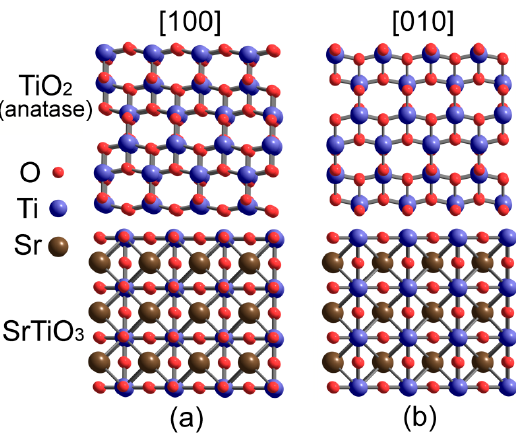
Figure 10. Structure of the heterointerface anatase TiO 2 (001) on SrTiO 3 (001) according to TEM image [125,126]. The views are along ( a ) the [100] and ( b ) the [010] directions.